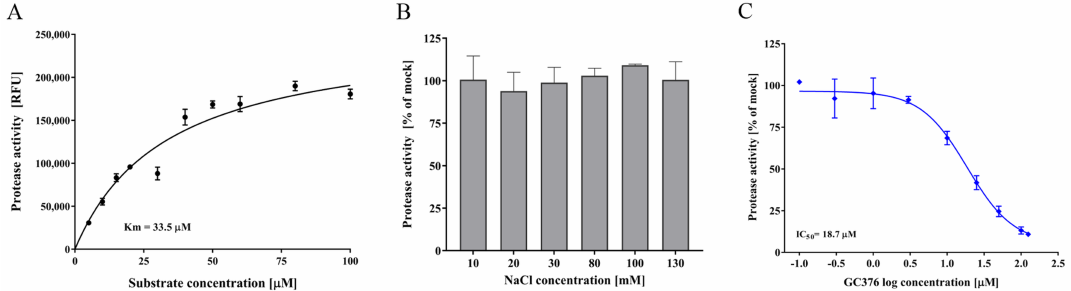
Figure 3. The enzyme kinetics and inhibition of the FCV protease. ( A ) Purified recombinant FCV protease and fluorogenic substrate Dabcyl-FRLE ↓ ADDG-Edans was used to measure the reaction velocity as a function of the substrate concentration (0 and 100 µ M). Following 1 h of incubation at 37 ◦ C, fluorescent signals were measured. Heat-inactivated FCV protease was used as a negative control. ( B ) The effect of NaCl concentration on protease activity. The baseline NaCl concentration of the reaction mixture before any additional NaCl was 3 mM. ( C ) Antiviral activity of the protease inhibitor GC376 against FCV. The half maximal inhibitory concentration (IC 50 ) for GC376 against the FCV protease was determined using a FRET assay. Concentrations ranged between 0.1 and 125 µ M and FCV protease activity was compared to DMSO treatment (vehicle only). Triplicate values from three independent experiments are shown as the mean ±